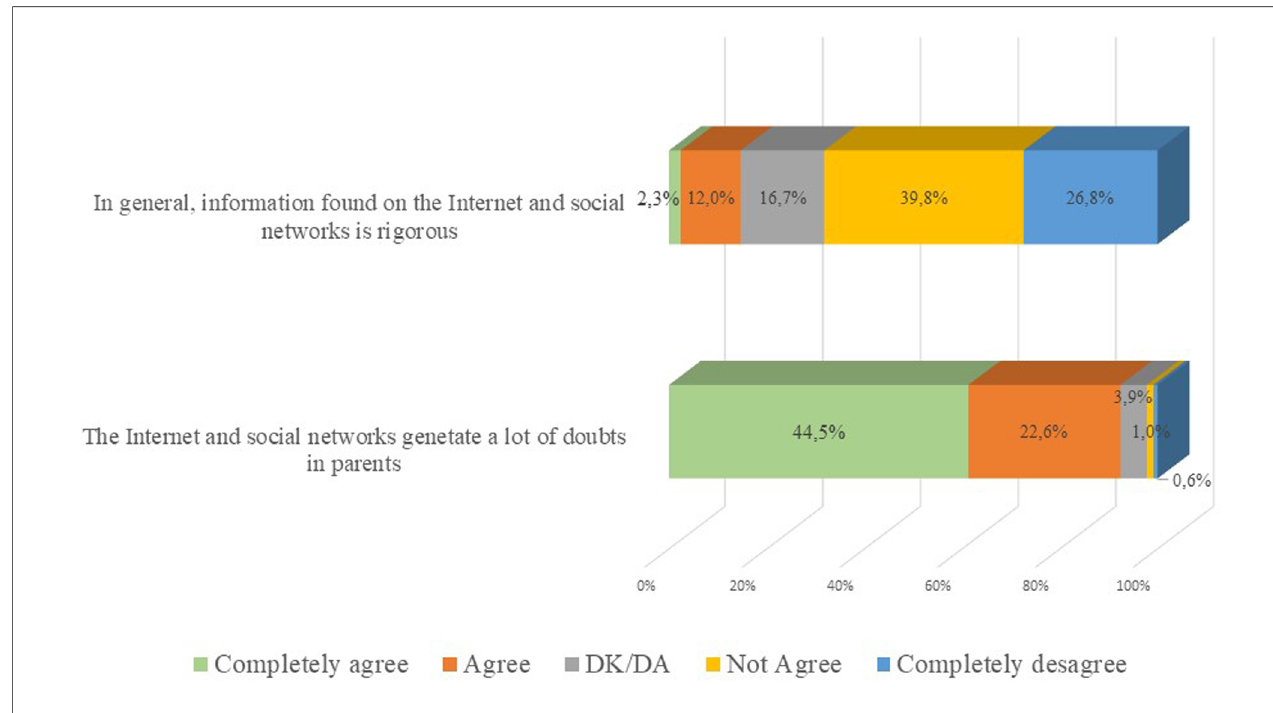
FIGURE 1 Statements on the internet and social networks as sources of